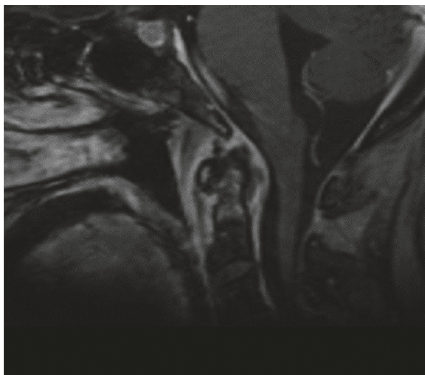
Figure 2: Sagittal postcontrast sequence demonstrating enhance- ment within the C2 odontoid process and surrounding prevertebral and epidural enhancing inflammatory soft tissue with liquefaction.